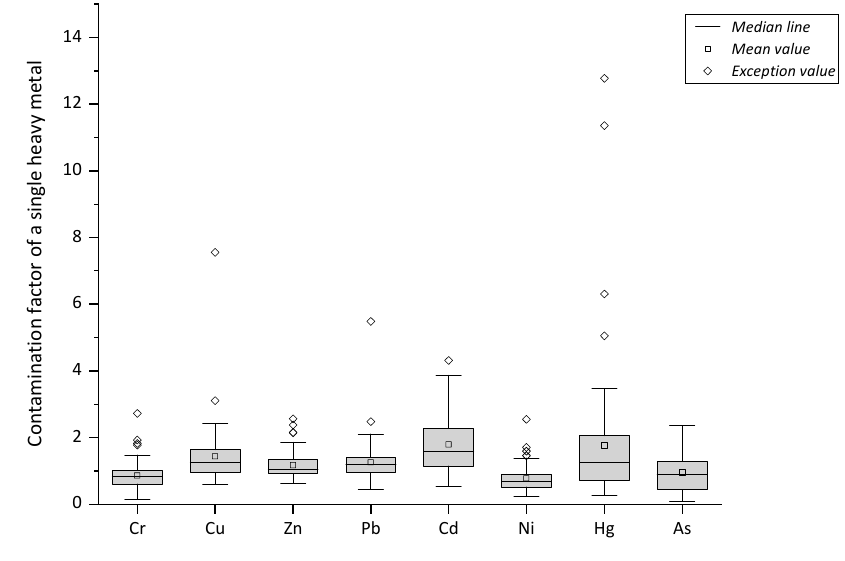
Figure 2. Distribution of the contamination factors of soil heavy metals. Table 8. Results of the comprehensive evaluation of soil heavy metal pollution.